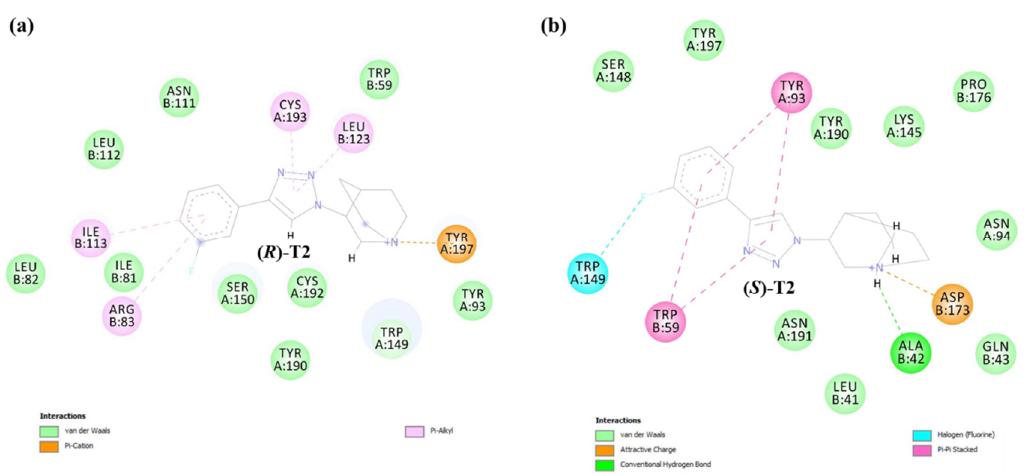
Figure 7. Molecular dynamics (MD) simulation of ( a ) ( R )-T2 and ( b ) ( S )-T2 with the α3β4 nAChR.